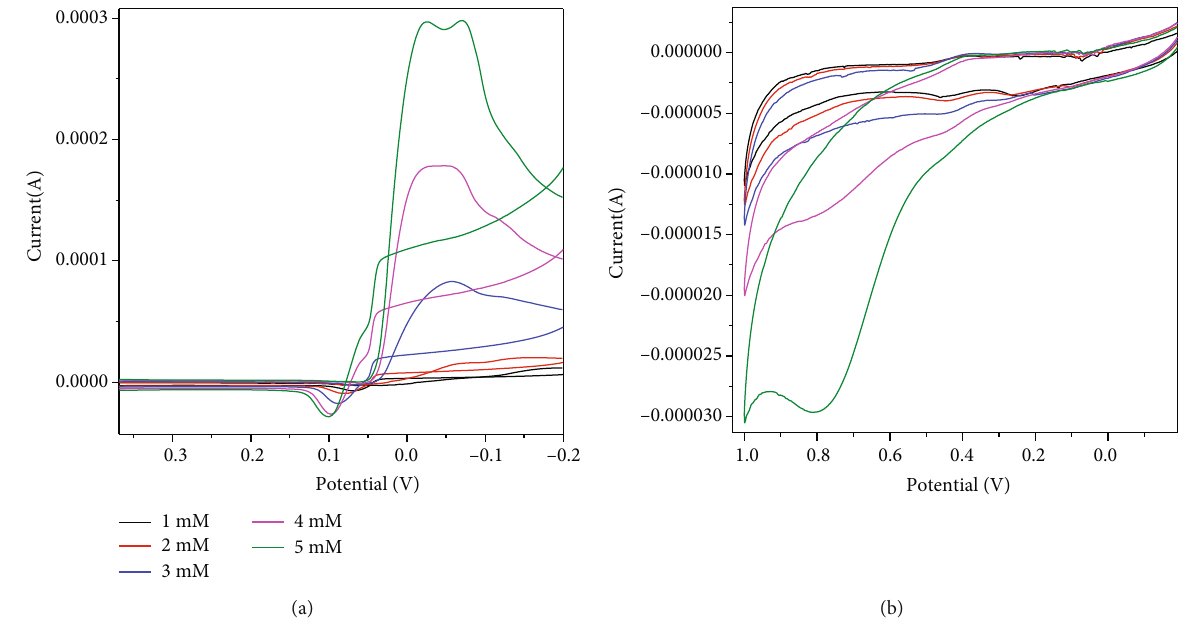
Figure 13: Cyclic voltammogram of ZrO :Dy 3+ (3 mol%) NP detection of (a) mercury and (b) lead of concentration range 2